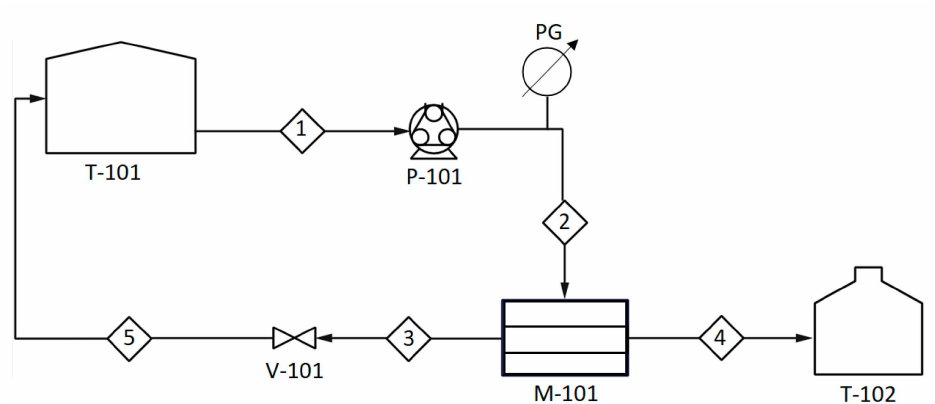
Figure 1. A schematic diagram of the experimental setup. Major stream, process unit, and instrumen- tations: feed tank (T-101), peristaltic pump (P-101), pressure gauge (PG), membrane module (M-101), control valve (V-101), retentate stream (3), and permeate stream (4). Modified based on our previous work